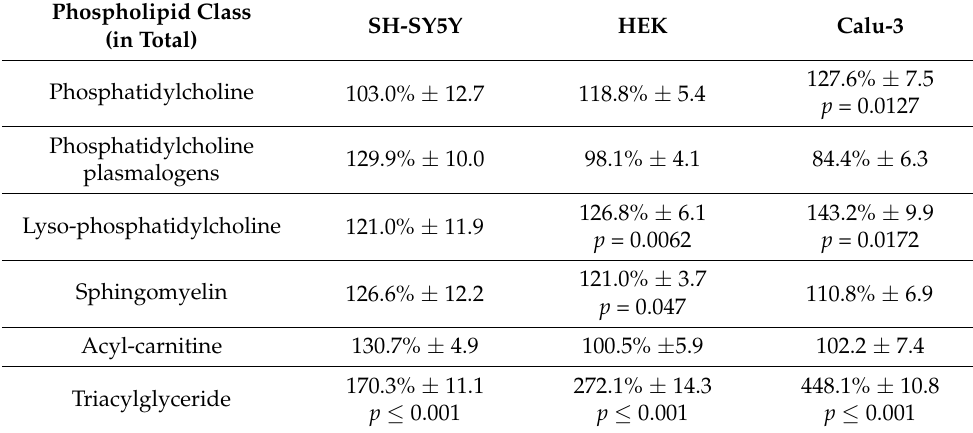
Table 1. Overview of all lipid classes examined. The percentage values in total for SH-SY5Y, HEK and Calu-3 cells treated with gemfibrozil compared to the solvent-treated control group are shown. In each case, the relative x-fold change with their standard error of the mean (SEM) in lipid species is shown. If statistical significance was reached, this is written underneath. A detailed list of all measured lipid data with additionally group analysis using the ANOVA test following by the Tukey post hoc test and a determination of homogenous groups for each lipid class can be found in the Supplementary Materials (see Supplementary Figure S2A–C and Supplementary Tables